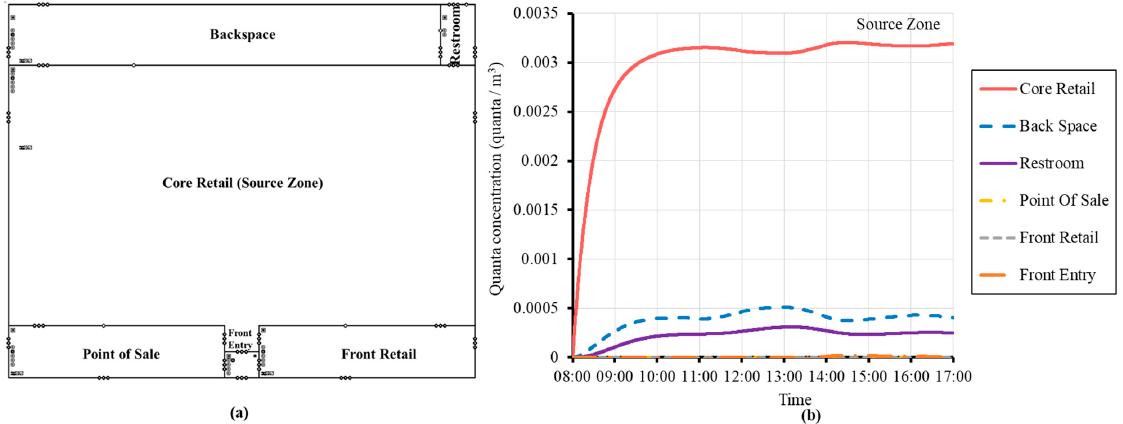
Figure 7. Stand-Alone Retail ( a ) top-view diagram of the Stand-Alone Retail and ( b ) quanta concen- tration as a function of time during a workday with the infector in the core zone on the first floor. Small icons in each room were contaminant generation source, deposition/deactivation items, and the supply/return of HVAC systems (small symbols).